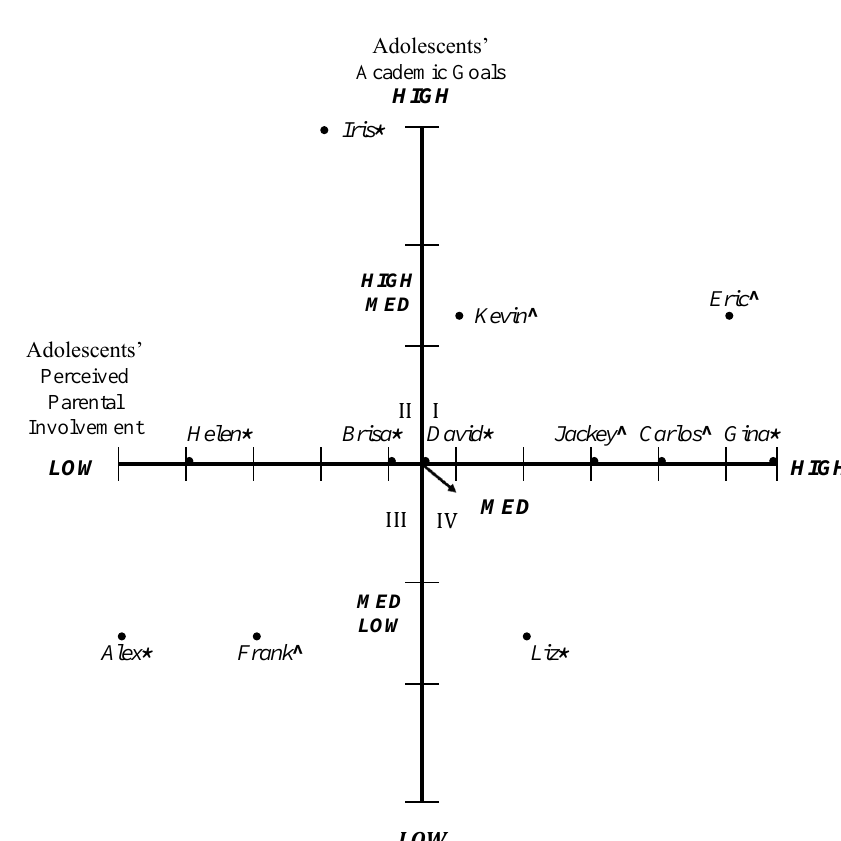
Figure 2. Adolescents’ perceived parental involvement and academic goals pre-program. Adolescent’s grade level: * = middle school; ˆ = high school. Quadrant I, six adolescents reported medium to high parental involvement and reported medium to high academic goals. Quadrant II, three adolescents reported low to medium parental involvement and reported medium to high academic goals. Quadrant III, two adolescents reported low to medium parental involvement and reported low to medium academic goals. Quadrant IV, one adolescent reported medium to high parental involvement and reported low to medium academic